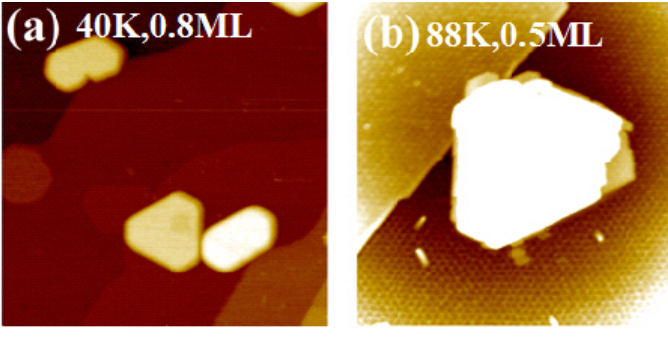
Figure 7. ( a ) 250 × 250 nm 2 area with only 3 large Pb islands the temperature is T = 40 K flux rate 0.1 ML/min and deposited amount θ = 0.8 ML. The islands have heights 8-, 6-, 7-layers from left to right. The measured island density 3 × 10 − 5 islands/nm 2